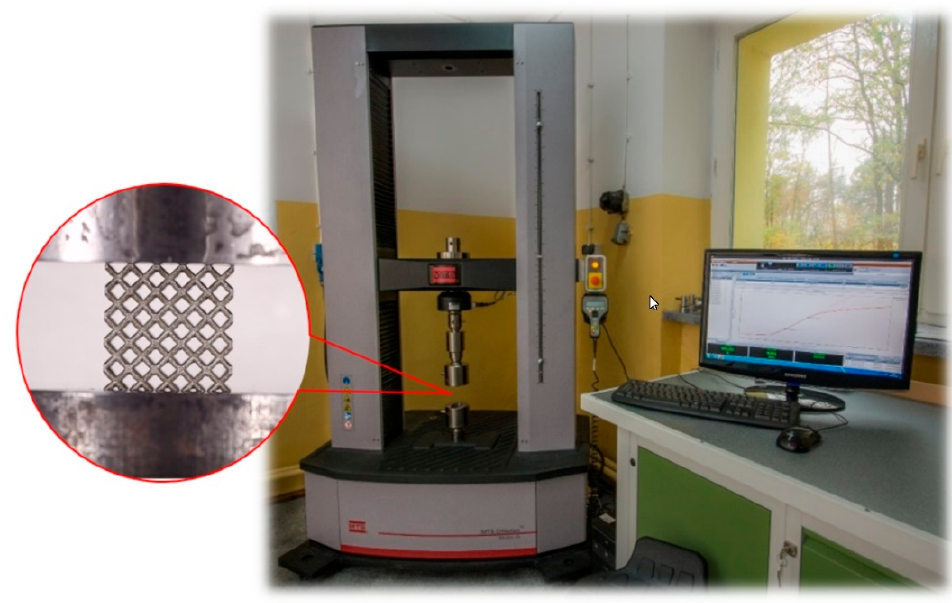
Figure 9. The general view of the universal tensile machine used to perform compression tests under quasi-static loading conditions.